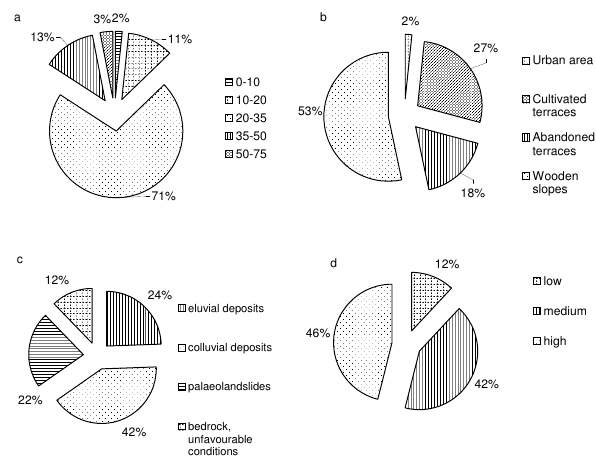
Fig. 6. Analysis of reported critical situations vs. acclivity (a) , land use (b) , geomorphological asset (c) and vulnerability (d)